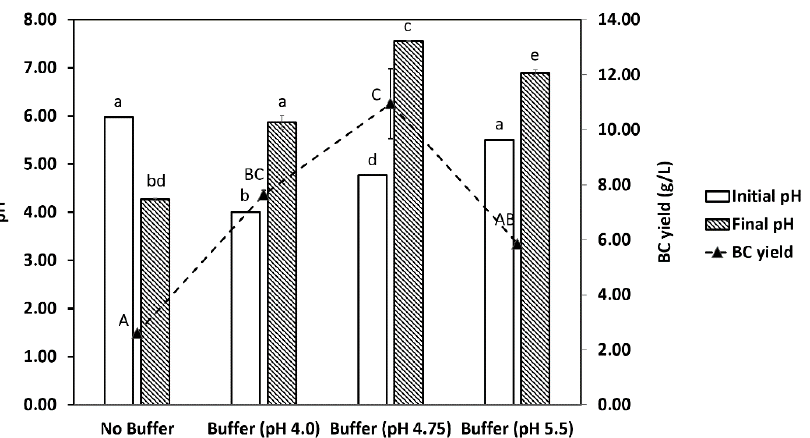
Figure 4. Effects of acetate buffer on pH and BC yield after 7 days of co-culture fermentation. Culture conditions: media composition, 150 g/L molasses, 500 mg/L caffeine, acetate buffer (no acetate buffer; 200 mM, pH 4.0, 4.75, 5.5); inoculum size, 10% v / v ; K. intermedius : D. bruxellensis ratio, 1:1; temperature, 30 °C. Different upper-case letters indicate significant differences ( p < 0.05) in BC yields.